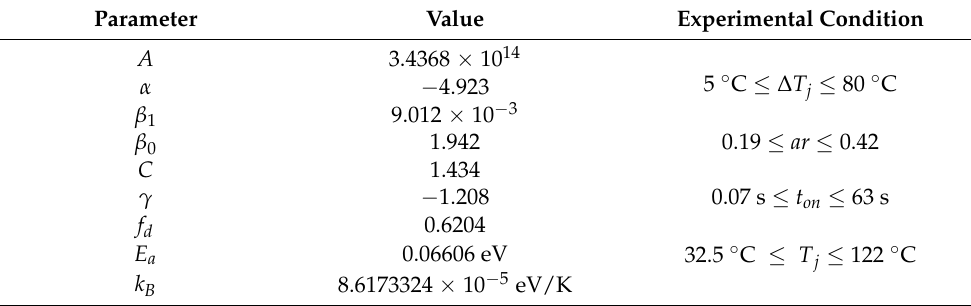
Table 12. Parameters of the lifetime model of an IGBT module. Parameter Value Experimental